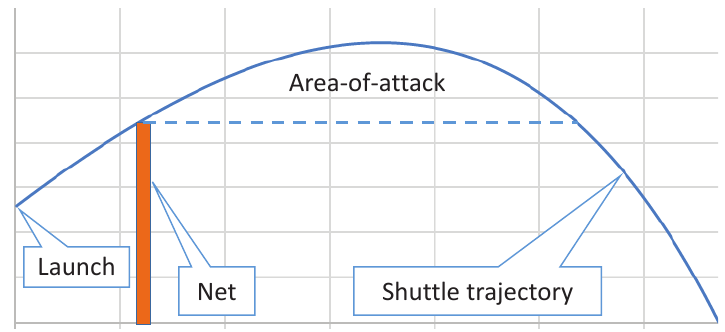
Figure 1. Definition of the